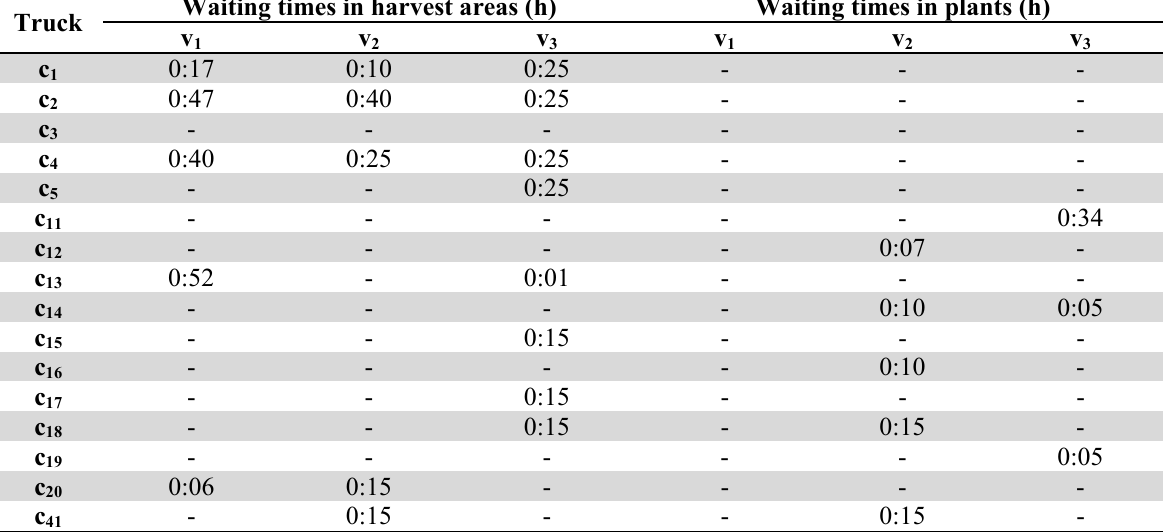
Waiting times in harvest areas and